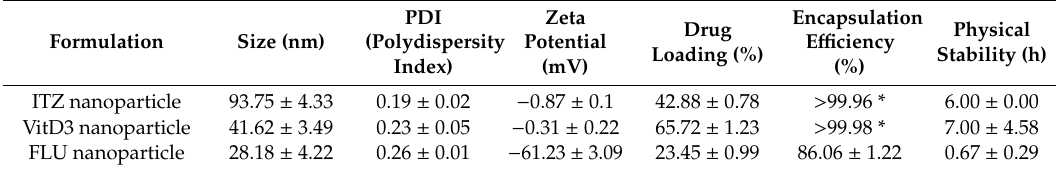
Table 3. The physicochemical properties of nanoparticles.